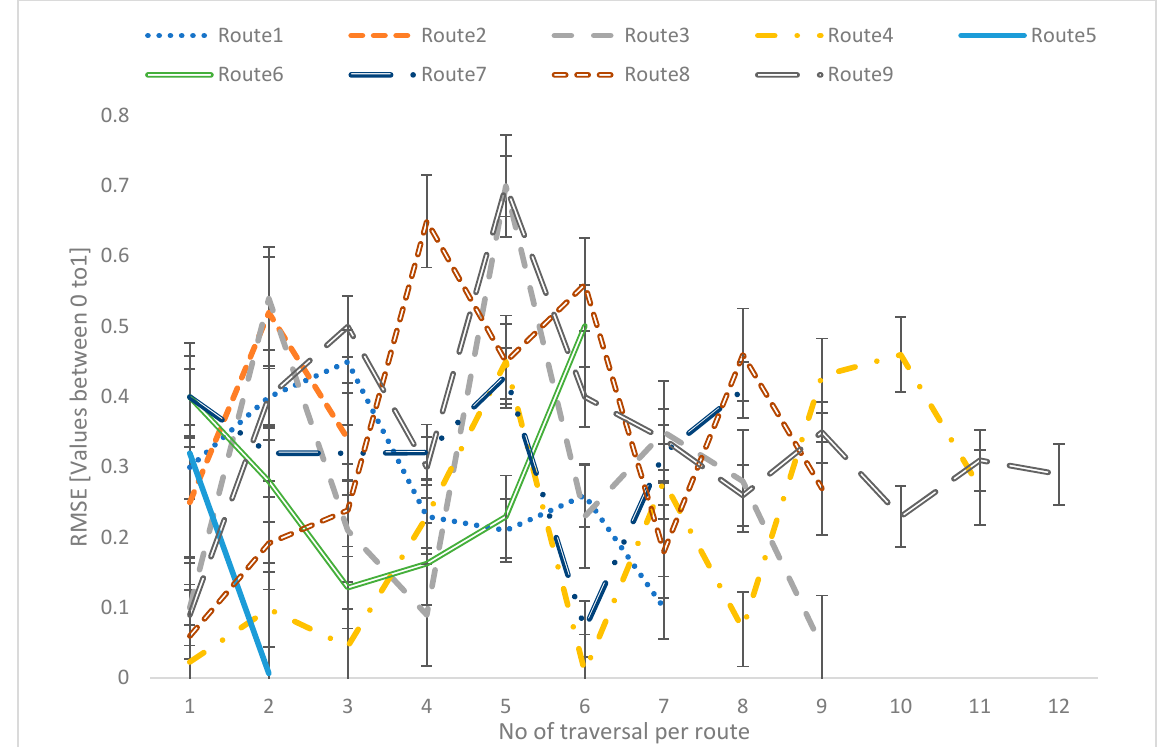
Figure 8. RMSE values corresponding to each traversal of the selected route.